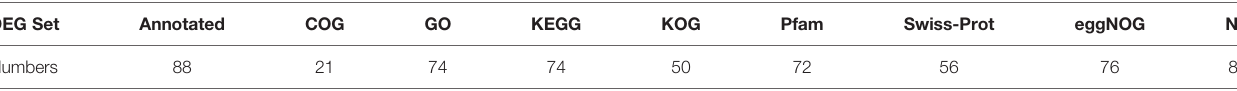
TABLE 4 | Number statistics of differentially expressed genes annotated.